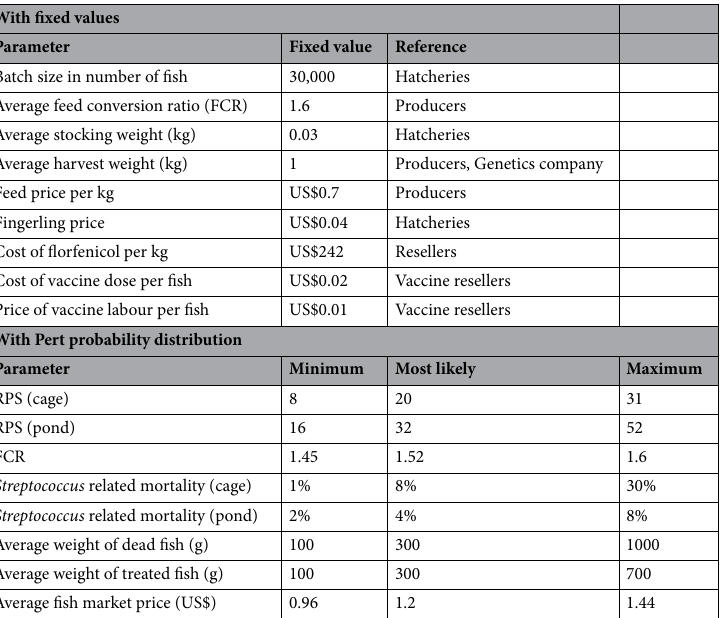
Table 1. Parameters included with fixed values and with Pert probability distribution in the economic model of using tilapia fingerlings resistant to Streptococcosis.